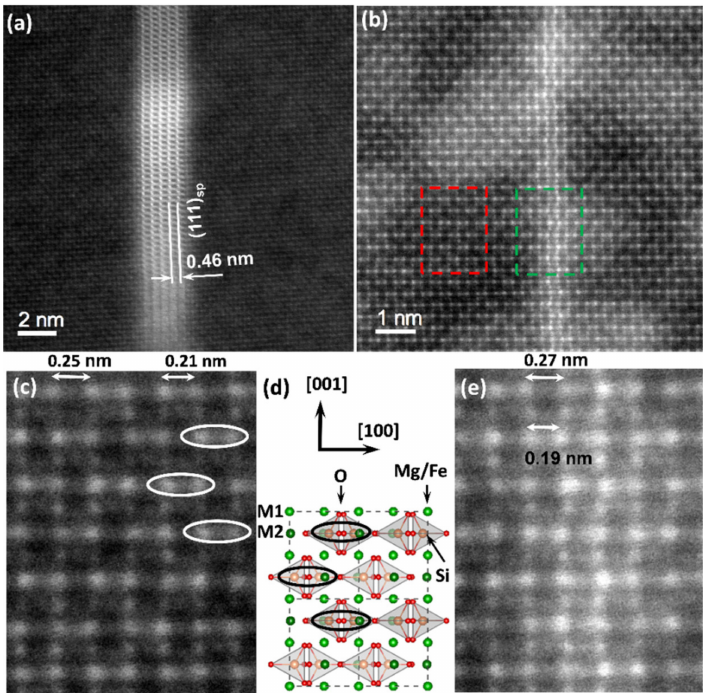
Figure 2. ( a ) HAADF image of thicker (100) platelets in olivine. ( b ) HAADF image of 4-atomic- planes-thick (100) planar defect in olivine (green dashed box). ( c ) Magnification of the olivine matrix in the area marked by the red dashed box in panel ( b ). In the HAADF image, the brighter columns correspond to a mixture of Si cations in tetrahedral position and Fe/Mg cations in the M 2 position. Along these atomic rows a doublet appears, depending on the orientation of the Si tetrahedra along the [100] axis, with short distances of ~0.21 nm (marked by white ellipses) and longer distances of ~0.25 nm. The Fe/Mg cations in the M 1 position appear less intense and are separated by a distance of ~0.225 nm. They alternate along the [001] axis with the Fe/Mg cations in the M 2 position. ( d ) The corresponding representation of the olivine crystal lattice in the (010) projection (orange is Si cation, red is O anion, green is Mg/Fe cations in M 1 or M 2 positions). Si tetrahedra are marked in gray. ( e ) Magnification of the thin planar defect in the area marked by the green dashed box in panel ( b ). A change, by up to ~20 ± 7 pm, of the distances between the mixed atomic columns that include Si cations in tetrahedral positions and Fe/Mg cations in the M 2 octahedral positions is